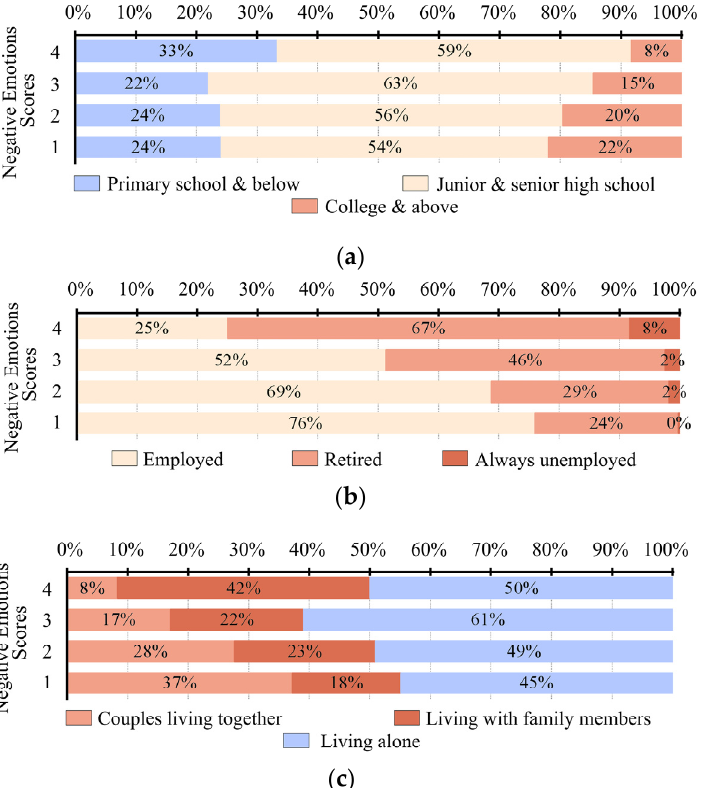
Figure 12. Changing trend of negative emotion scores based on influencing factors: ( a ) education background; ( b ) employment status; ( c ) living arrangements.